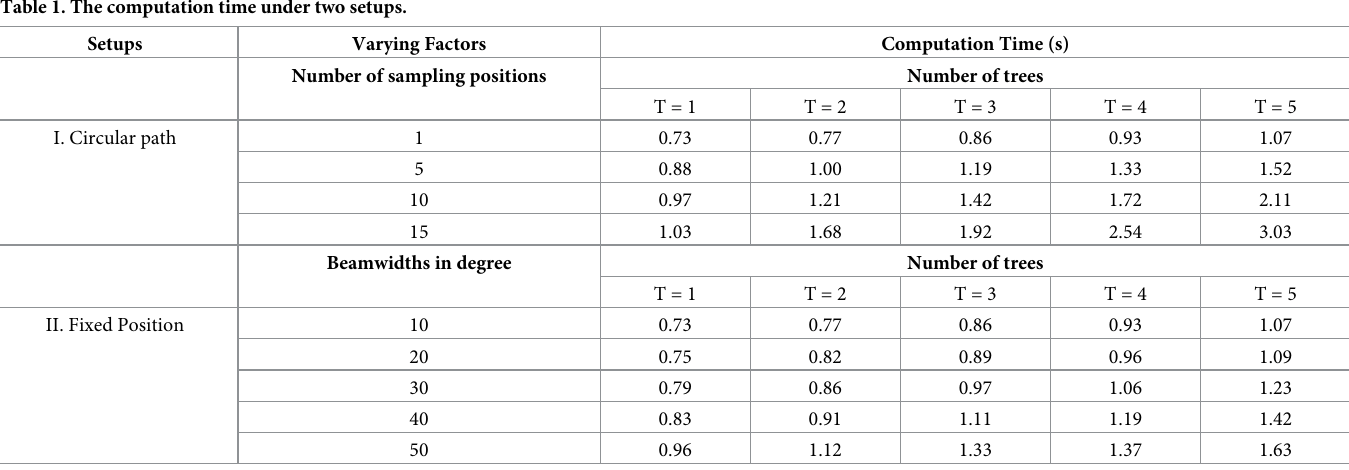
Table 1. The computation time under two setups.